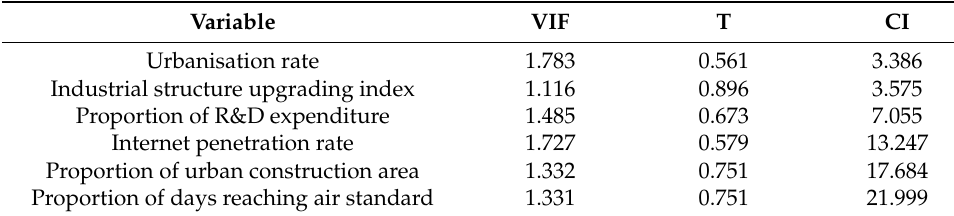
Table 4. Results of multicollinearity